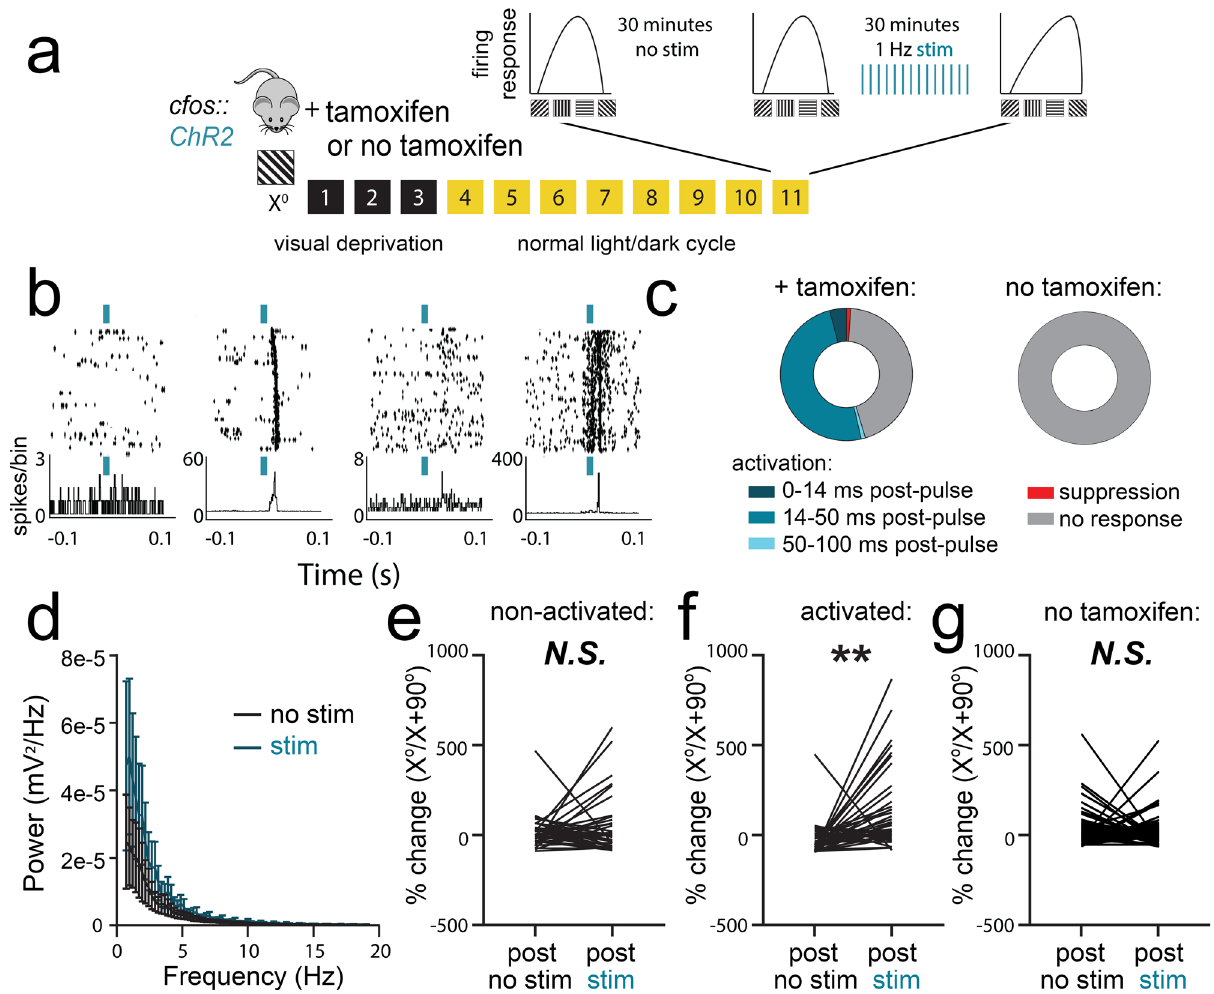
Fig. 5 Of fl ine reactivation of orientation-selective TRAPed V1 neurons alters orientation representations in V1. a cfos::ChR2 mice were presented with an oriented grating ( X °) for TRAP. A second cohort was treated identically, without tamoxifen administration to induce recombination (no tamoxifen). Eleven days later, orientation tuning was measured repeatedly for V1 neurons recorded from anesthetized mice: at baseline, after a 20 – 30-min period without optogenetic stimulation, and after a 20 – 30-min period with 1 Hz light delivery. b Representative rasters and perievent histograms for four simultaneously recorded neurons, showing diverse fi ring responses during optogenetic stimulation of ChR2-expressing neurons. c The majority of stably recorded V1 neurons were reliably activated following light pulses, with variable lag times. A small proportion were inhibited by light delivery, and the remaining neurons were not affected ( n = 96 neurons from 6 mice, total). Neurons recorded during rhythmic light delivery in control (no tamoxifen) mice showed no responses to light pulses ( n = 79 neurons from 5 mice, total). d Power spectra for V1 LFPs showed no signi fi cant effect on ongoing rhythmic activity (N.S., K – S test, n = 5 mice). Values indicate mean ± SEM. e , f After optogenetic stimulation, neurons that were not activated following light pulses showed no change in orientation preference (N.S., nested t test, n = 37 neurons from 5 mice). In contrast, activated neurons showed increased fi ring rate responses for gratings of the same orientation ( X °) used for TRAP. (** p = 0.004 [ t = 3.93, DF = 8], nested t test, n = 40 neurons from 5 mice). g Neurons in control (no tamoxifen) mice showed no consistent orientation preference changes following rhythmic light delivery (N.S., nested t test, n = 79 neurons from 5